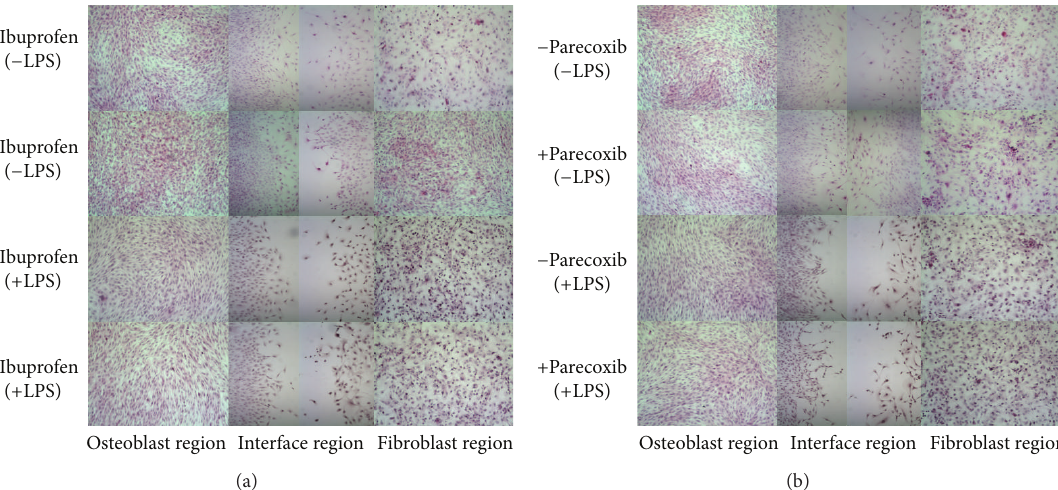
Figure 5: Microscopic morphology of the osteoblast, interface, and fibroblast regions during bone-tendon healing in vitro . Seven days following exposure to ibuprofen or parecoxib, murine cocultures were stained with hematoxylin and eosin, and representative regions were observed and photographed (20x magnification). 𝑃 values are provided as follows: ∗ 𝑃 < 0.05 , ∗∗ 𝑃 < 0.01 , and ∗∗∗ 𝑃 < 0.001